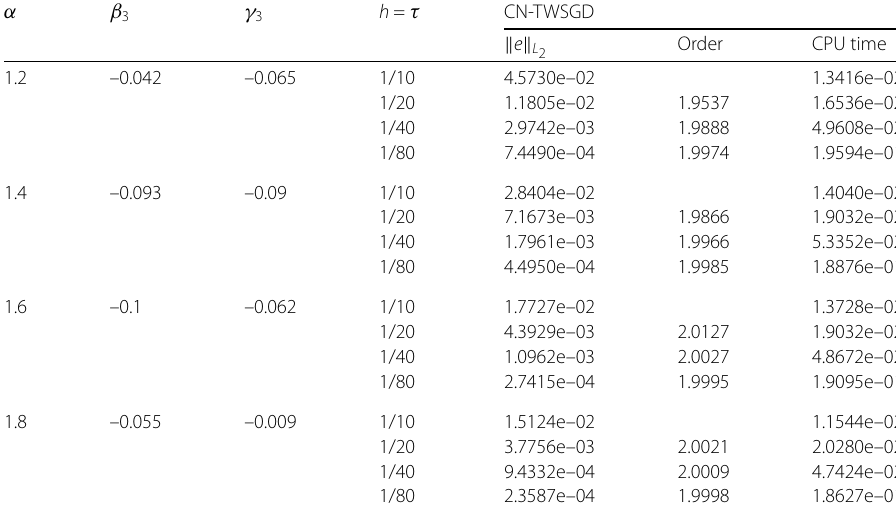
Table 8 Errors and corresponding observation orders at t = 1, λ =